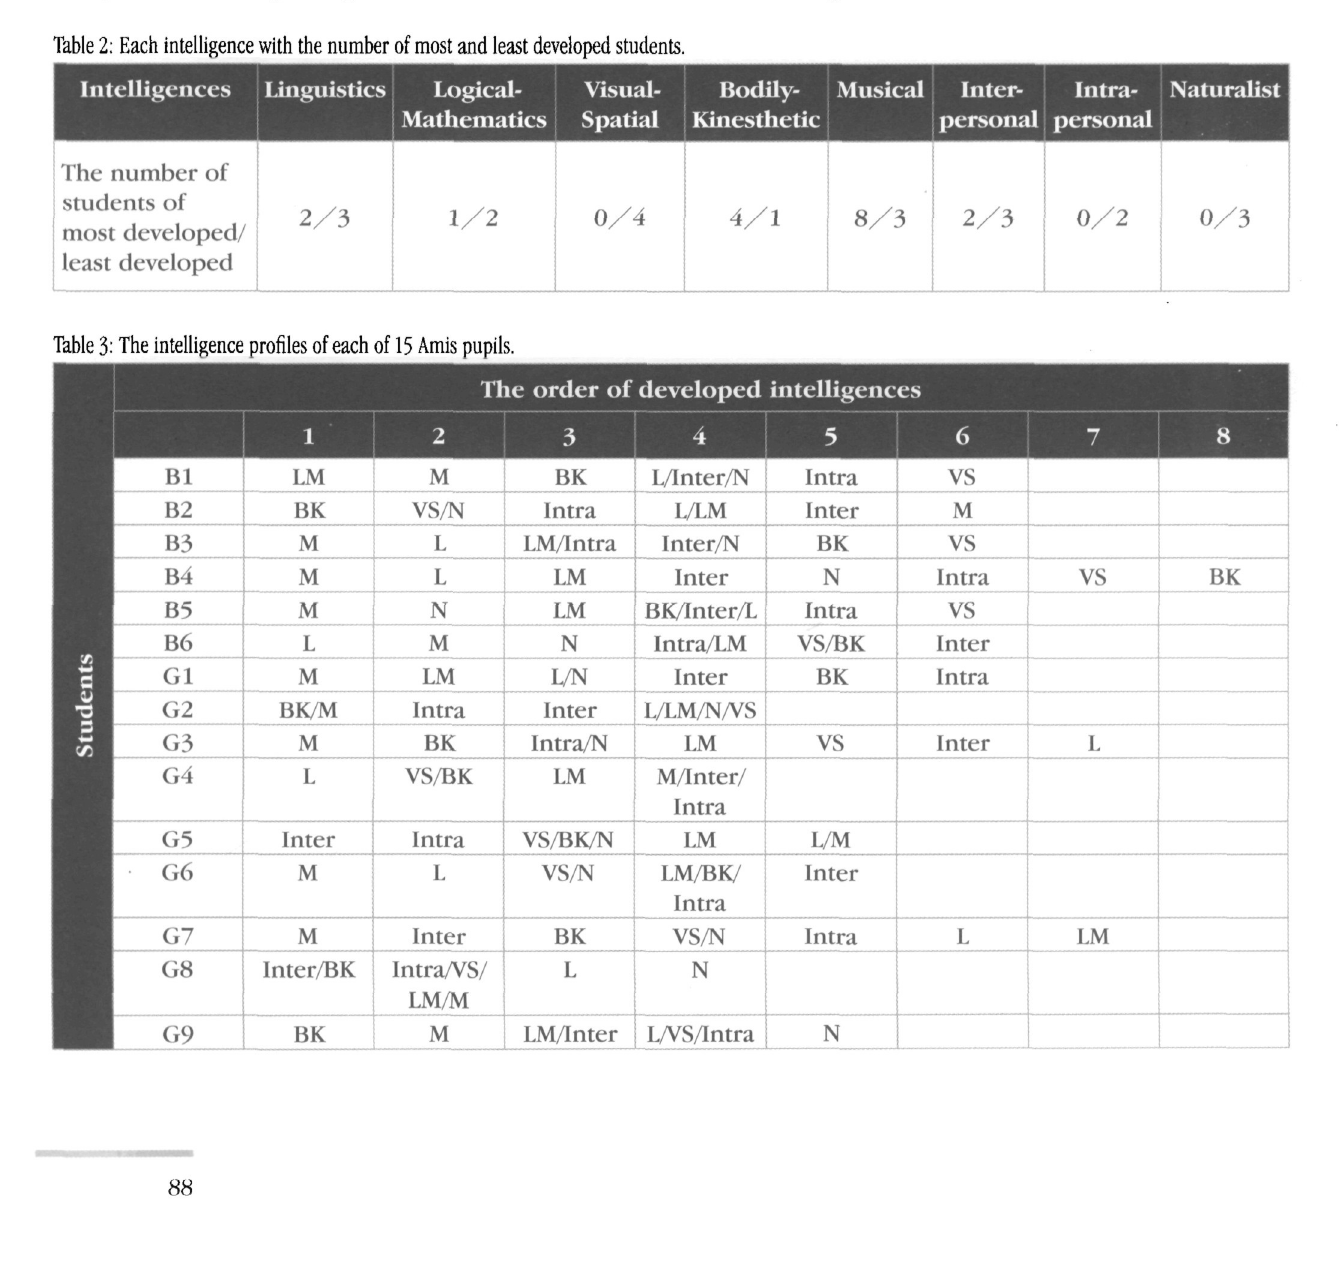
students.students